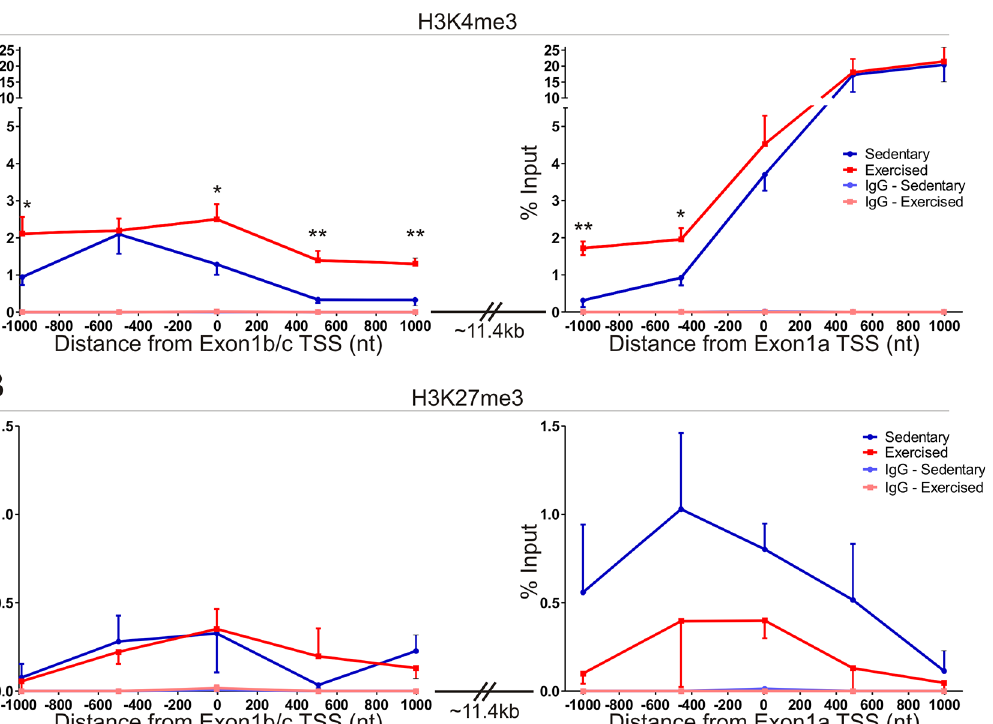
Fig 3. Chromatin Immunoprecipitation of histone modifications across Exon 1a and Exon 1b/c transcriptional start sites of PGC-1 α . (A) Presence of an activating histone modification (H3K4me3) was examined via qPCR 1000bp in each direction from the transcriptional start site of Exon 1a (left) or Exon 1b/c (right). (B) Presence of a repressing histone modification (H3K27me3) was examined via qPCR 1000bp in each direction from the transcriptional start site of Exon 1a (left) or Exon 1b/c (right). 2-way ANOVA analysis found significant difference between the level of H3K4me3 only across the Exon 1b/c transcriptional start site (p < 0.0001). Individual points were compared for statistical significance using student ’ s t-test ( * p < 0.05, ** p <